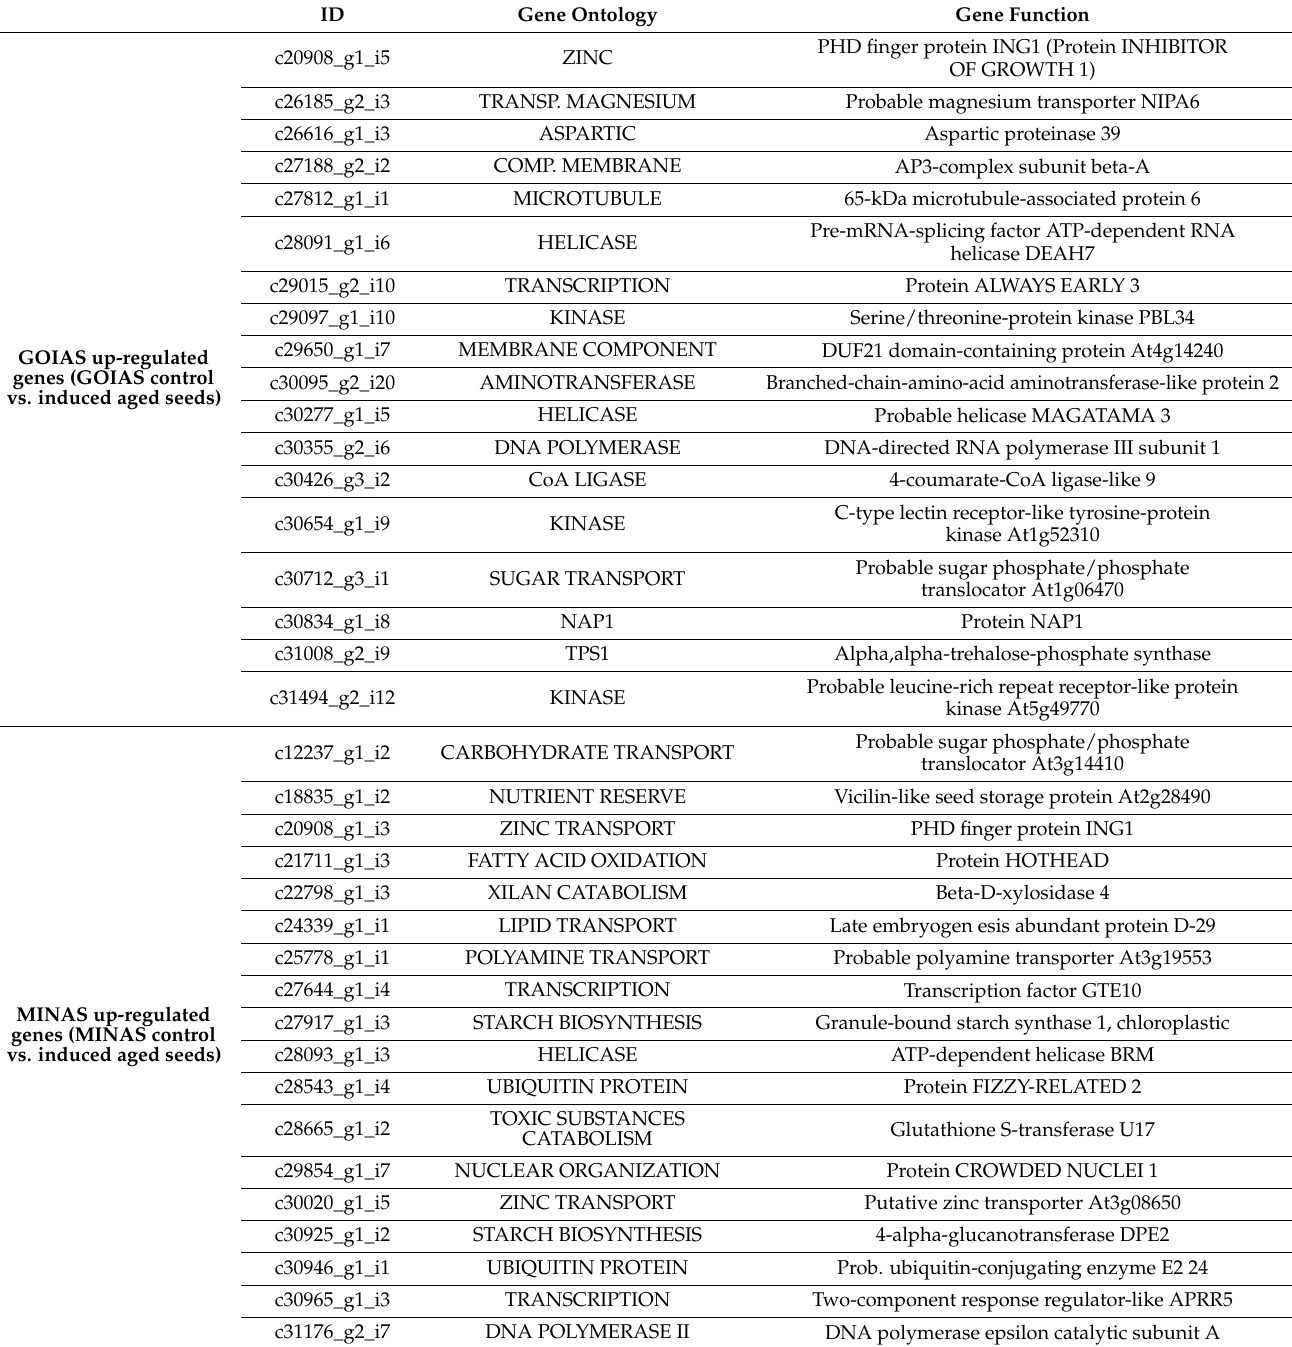
Table 3. Selection of up- and down-regulated genes of treatments with a possible relation to the aging of A. fraxinifolium